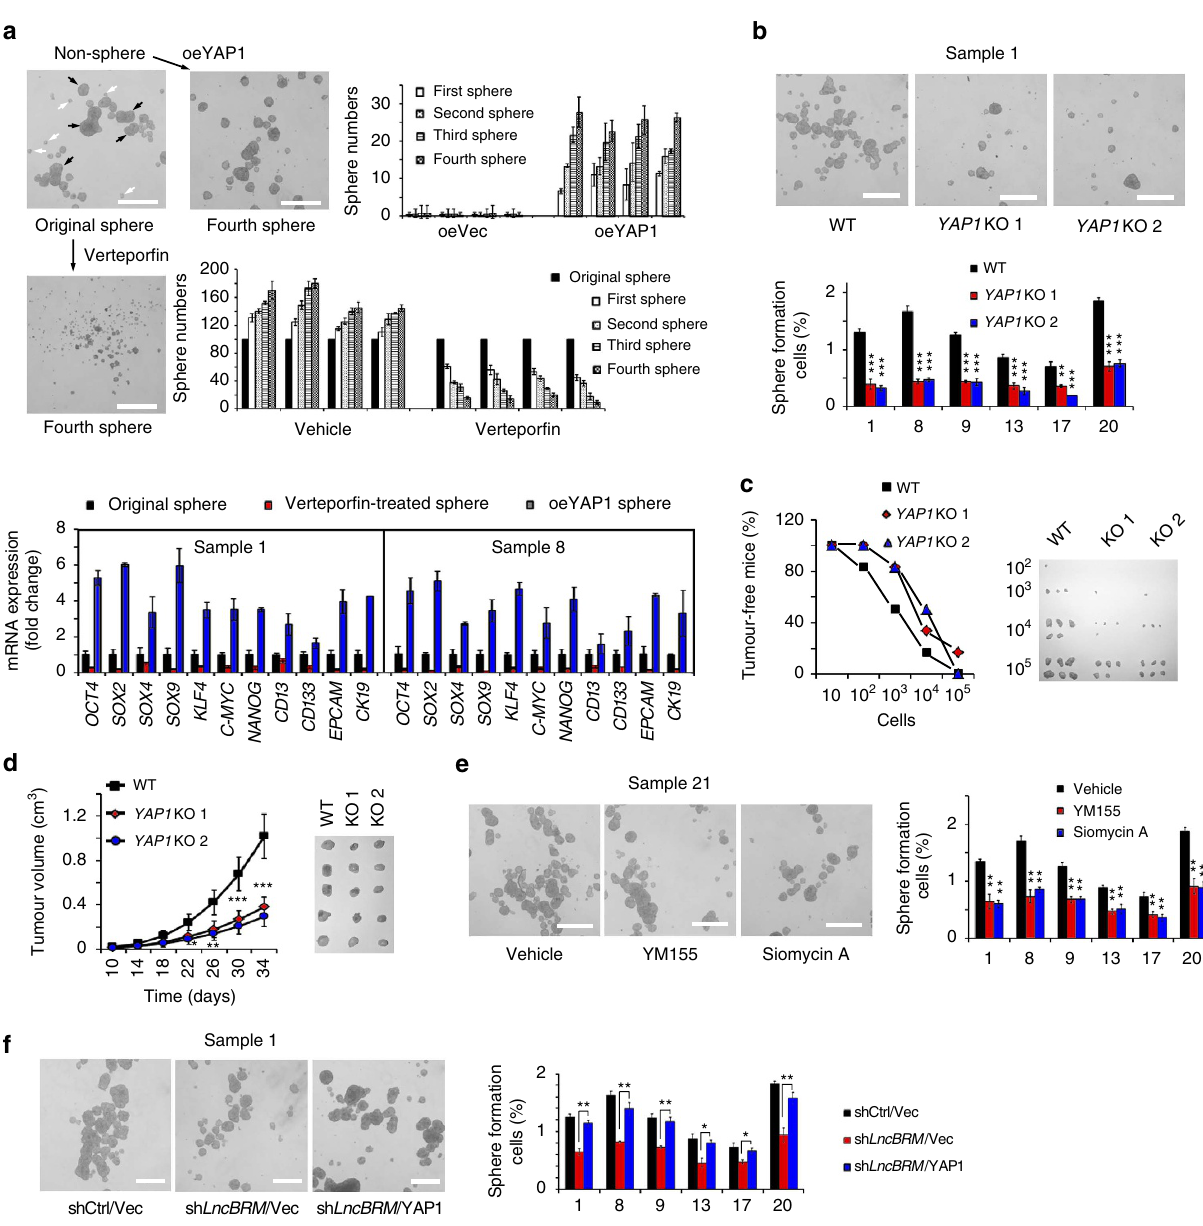
Figure 6 | LncBRM -mediated YAP1 signalling is required for self-renewal of liver CSCs and tumour propagation. ( a ) YAP1 was activated (overexpression) or inactivated (Verteporfin treatment) in non-sphere cells or sphere cells, followed by measurement of self-renewal by serial sphere formation assays. Fourth passage spheres and sphere numbers were shown (upper two panels). Two weeks later, original spheres, Verteportin-treated spheres and YAP1-overexpressing spheres were collected for mRNA detection (lower panels). ( b ) YAP1 KO cells ( YAP1 KO) were used for sphere formation assays. ( c ) Wild-type (WT) and Yap1- deficient cells (10, 10 2 , 10 3 , 10 4 and 10 5 ) were injected into BALB/c nude mice for measurement of tumour formation. Tumour-free mice and established tumours were shown. n ¼ 6 for each group. ( d ) 1 (cid:3) 10 6 YAP1 KO and control cells were injected into BALB/c nude mice for tumour growth. Tumour volume was calculated every 4 days. n ¼ 5 for each group. ( e ) HCC primary tumour cells were treated with YM155 and Siomycin A for sphere formation assay. ( f ) YAP1 was rescued in lncBRM -depleted cells using pBPLV lentivirus and followed by sphere formation assay. Scale bars, 500 m m ( a , b , e , f ). Data are shown as means ± s.d.; * P o 0.05, ** P o 0.01 and *** P o 0.001. Data are representative of four independent